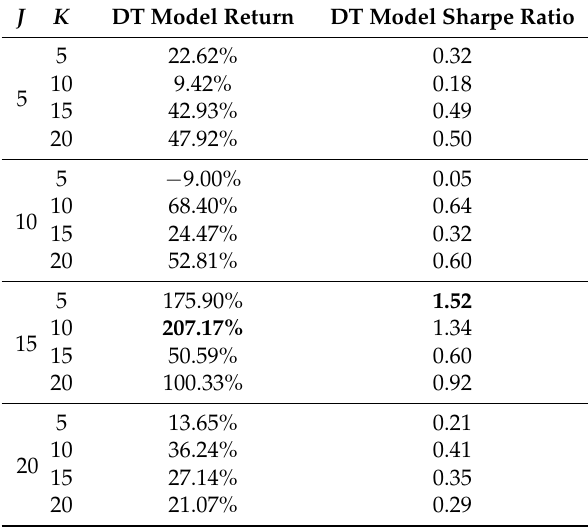
Table 6. Performance of the Decision Tree (DT) model.